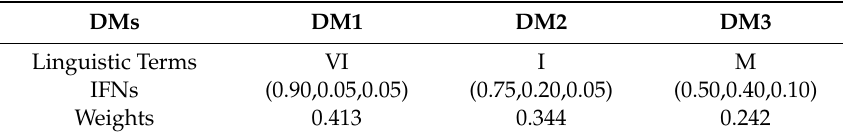
Table 4. Decision makers’ weights.